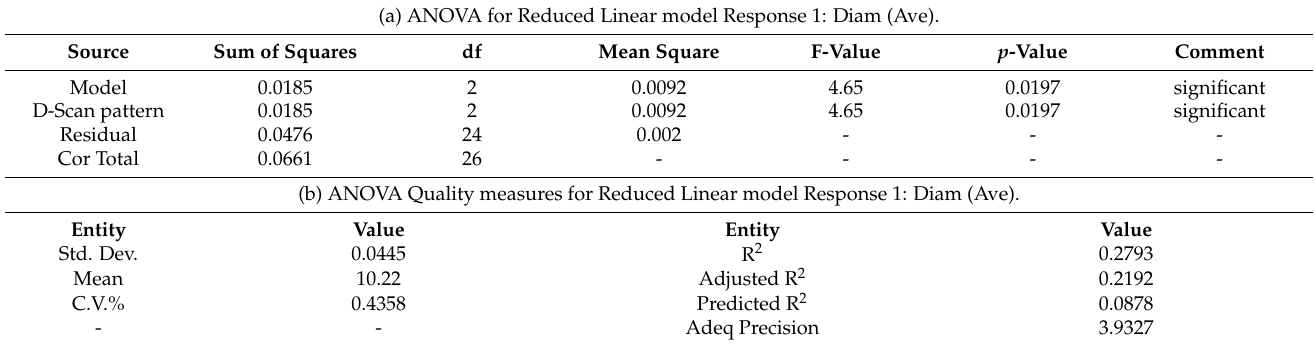
Table A1. ANOVA results: External